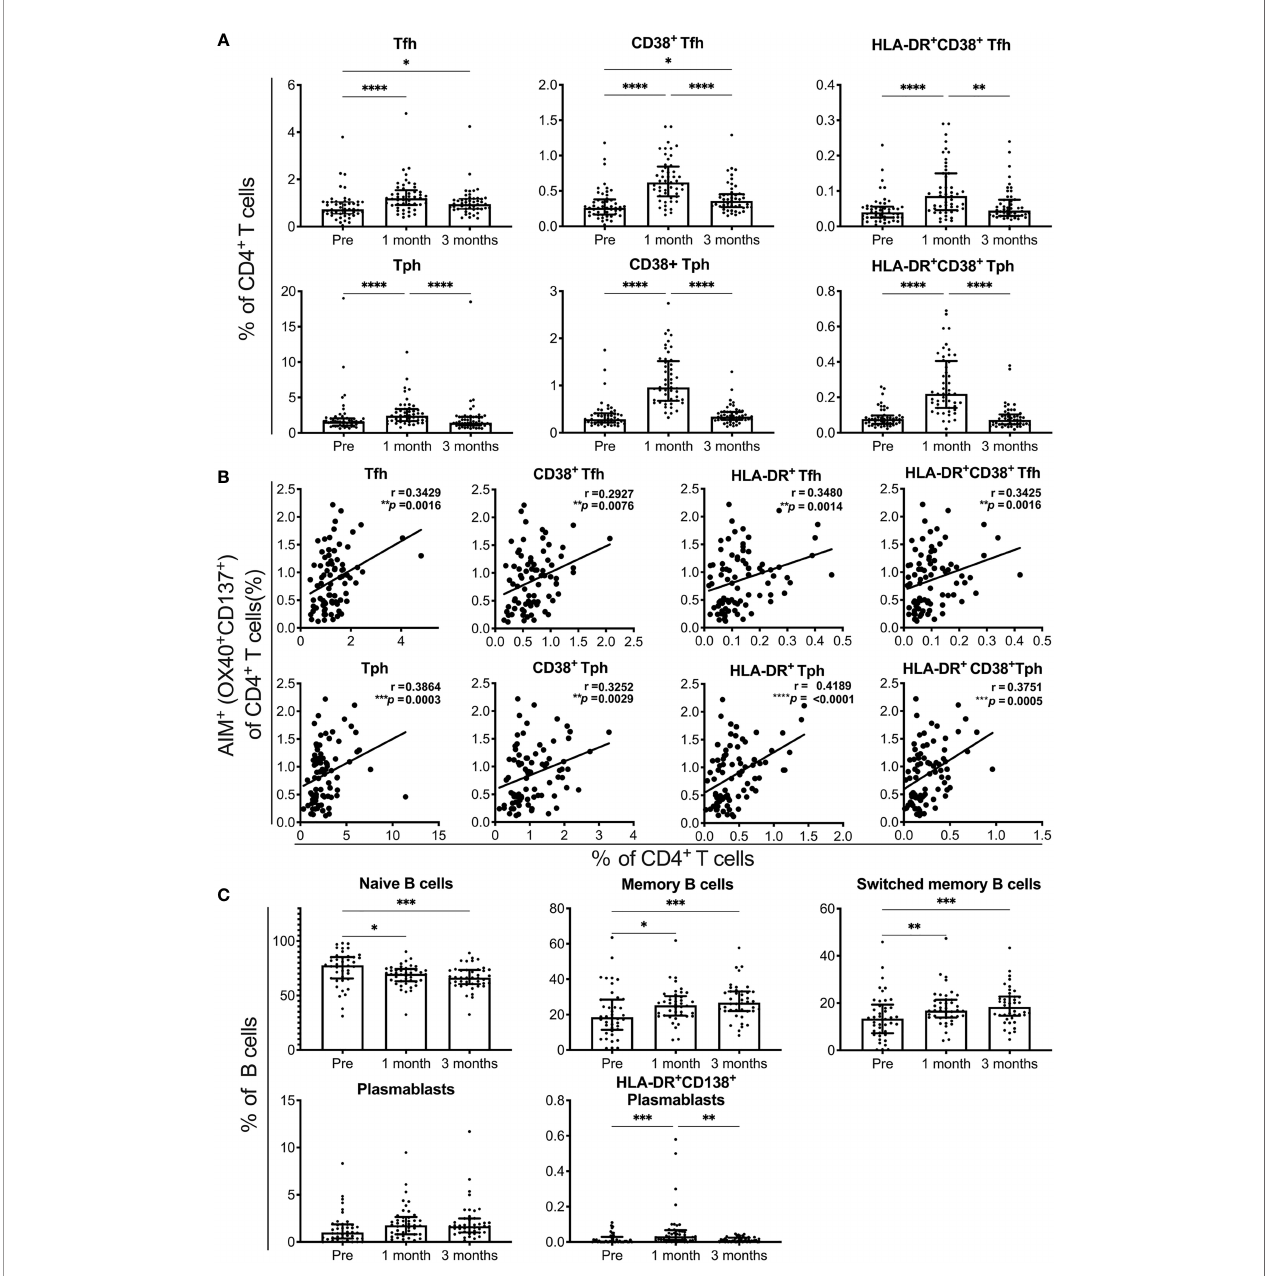
FIGURE 3 | SARS-CoV-2 mRNA vaccination-induced responses of T and B cell subsets. Flow cytometry analysis of peripheral blood mononuclear cells from individuals pre-, and 1 and 3 months post-vaccination. A detailed gating strategy is shown in Figure S3 . (A) The percentages of T follicular helper (Tfh), T peripheral helper (Tph) cells, CD38 + and CD38 + HLA-DR + Tfh, and Tph cells. (B) The correlation of AIM + CD4 + T cells reactive to the S1 peptide pool with total Tfh and Tph cells, and activated Tfh and Tph cells at 1 month post-vaccination. (C) The percentages of naïve B, memory B, switched memory B cells, plasmablasts, and HLA- DR + CD38 + plasmablasts are shown. Each dot indicates the value of one individual. The box indicates the median and the whiskers indicate the fi rst and third quartiles (A, C) . (A, C) *p < 0.05, **p < 0.01, ***p < 0.001, ****p < 0.0001 (Friedman test). (B) Correlations were analyzed using Spearman ’ s correlation